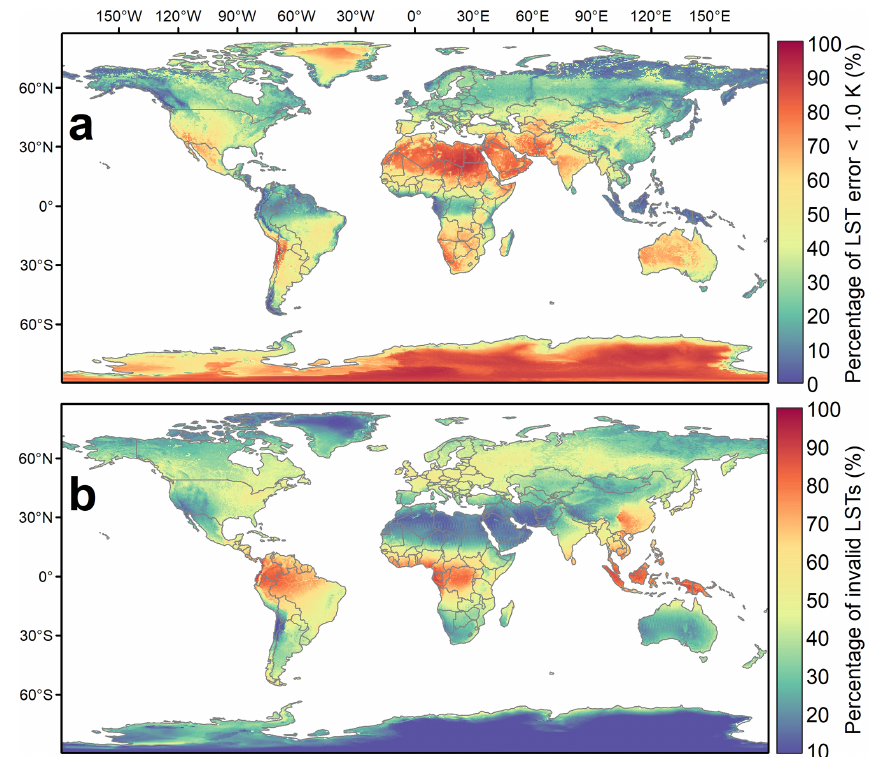
Figure A2. Uncertainties of the downloaded MODIS MXD11C1 V6 LSTs. Panel (a) shows the percentage of LSTs with a retrieval error less than 1.0K, and panel (b) displays the percentage of invalid data ( ≈ clouds).